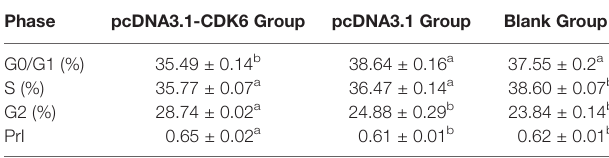
TABLE 2 | Cell proliferation index (PrI) after pcDNA3.1-CDK6 plasmid